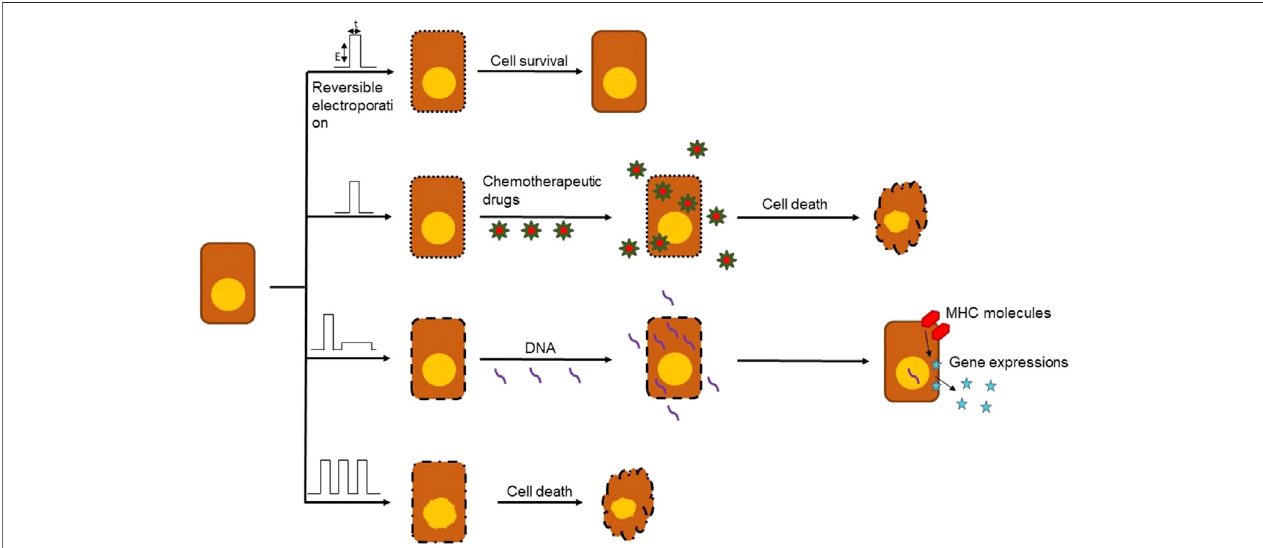
FIGURE 2 | Different outcomes of electroporation based on type, frequency, amplitude and number of EPs. Electroporation can be used in a number of ways to damage cancerous cells like delivery of chemotherapy drugs, DNA vaccines and cell death.